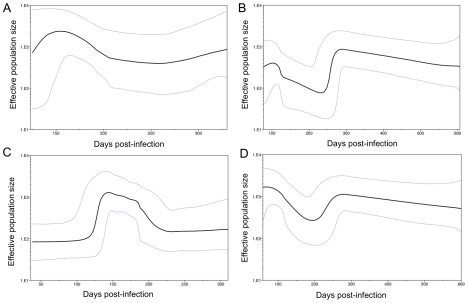
Demographic reconstruction of the viral populations.Demographic reconstruction from E1/HVR1 (A,B) and E2 (C,D) sequences for subjects who developed chronic infection, 23_Ch (A,C) and 240_Ch (B,D). In both subjects, and in both genomic regions, the founder effect and sequential bottleneck events are evident. The estimated effective population size (Nτ, the product of the effective population size and generation length in days) had a peak value of the order of 103, and then decreased to values of the order of 102. The longer estimate of tMRCA for 23_Ch when compared to those in Table 1 is likely to be due to the presence of two founder viruses in this subject.